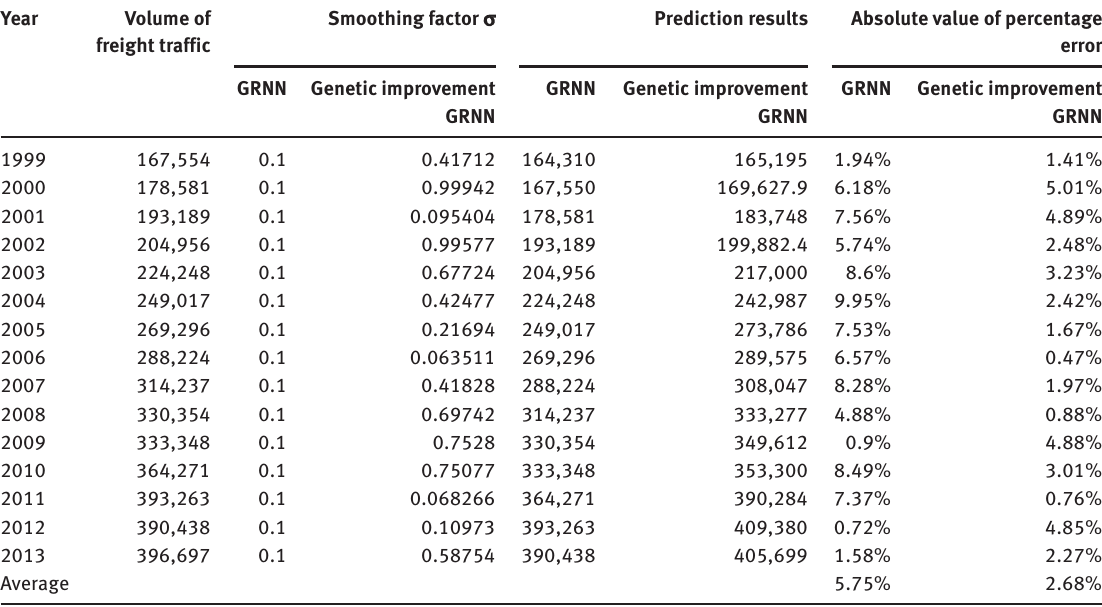
Table 2: Prediction Results of GRNN and Genetic Improvement in